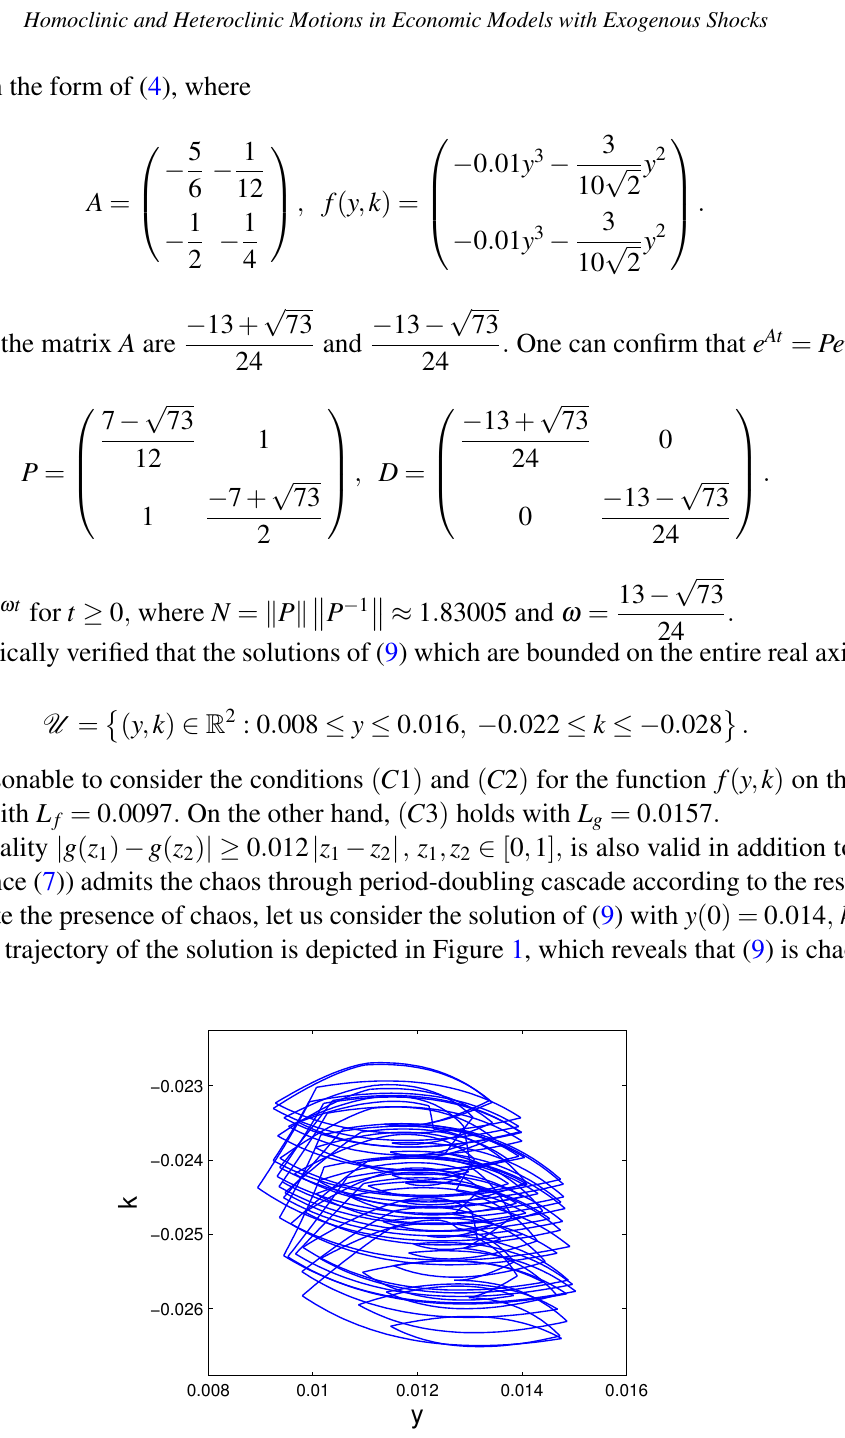
Fig. 1 The trajectory of system (7) corresponding to the initial data y ( 0 ) = 0 . 014 and k ( 0 ) = − 0 . 025 . The solution of (8) with d 0 = 0 . 18 is used in the